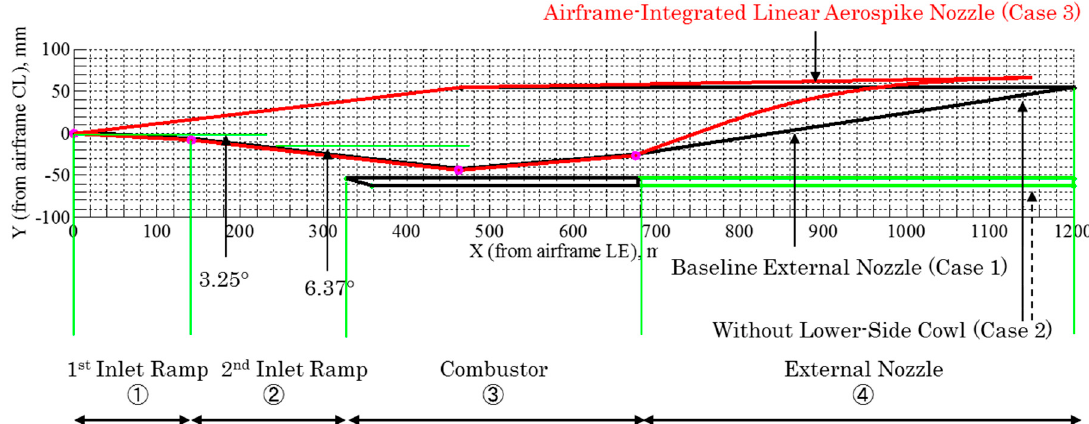
Figure 4. Illustration of a center cut of the airframe configuration equipped with the airframe-integrated linear-spike aftbody nozzle, describing dimensions of airframe and propulsion systems.